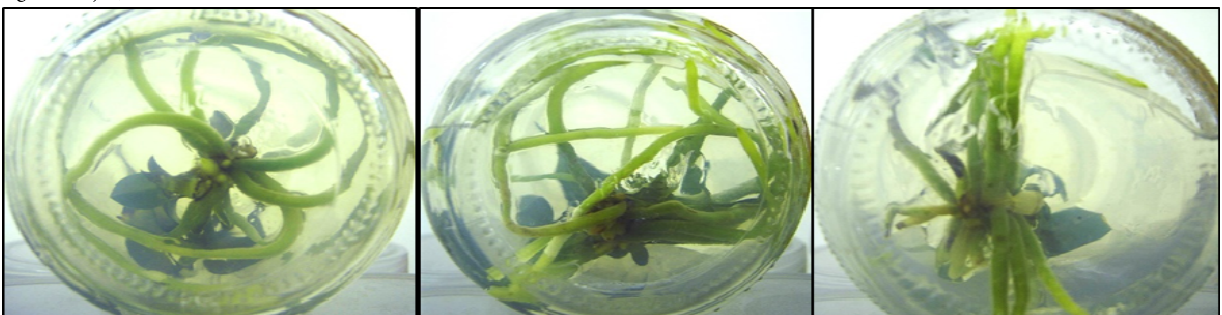
Fig. 1. In vitro better root formation of orchid plantlets on 3.0 mg l -1 NAA (right jar) compared to 0.1 and 1.0 mg l -1 NAA (left to right two jar)